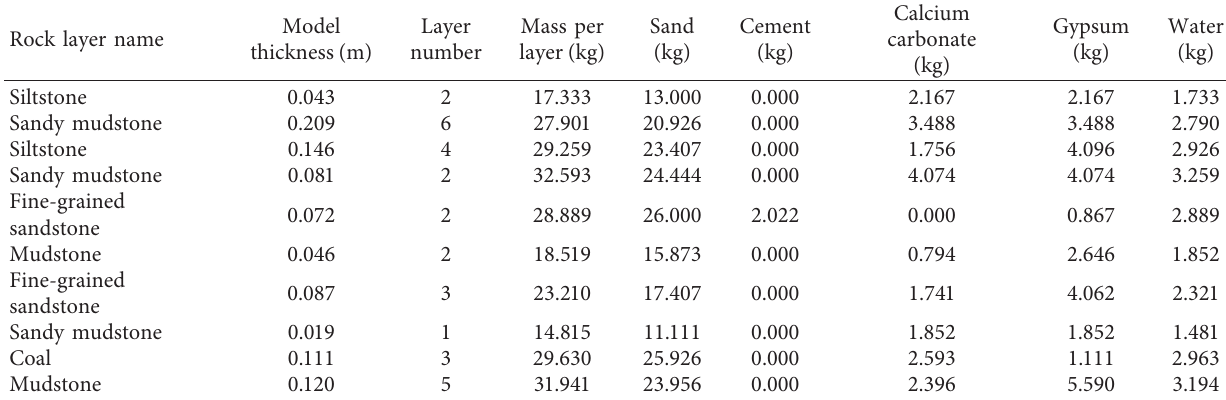
Table 3: Layer programs and mixture ratios of similar model.